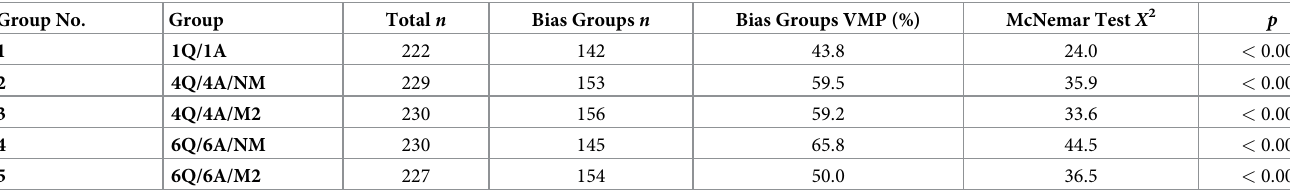
Table 5. Experiment 3: Pre- and Post-IPA VMPs. Group